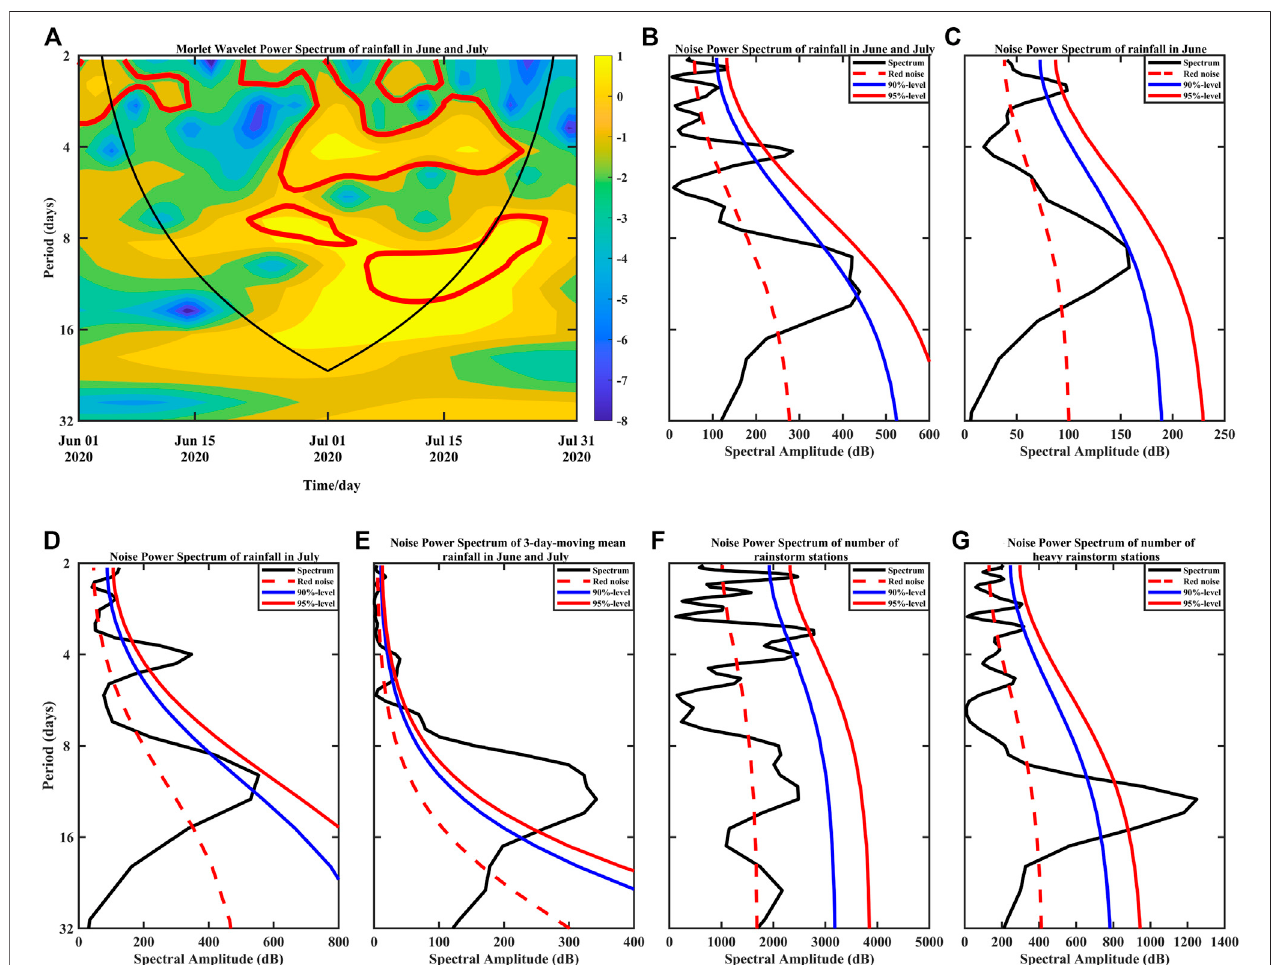
FIGURE 5 | (A) Local wavelet power spectrum of series of daily averaged precipitation from June 1, 2020, to July 31, 2020, in Figure 1B using Morlet wavelet analysis (thick red contour encloses regions of greater than 95% con fi dence for a red-noise process). (B) Noise power spectrum analysis of series of daily mean precipitation in Figure 2B (dashed red line is for red noise spectrum). Solid blue/red line is for 95/90% con fi dence level for spectrum. (C) as in (B) but for series of precipitation in June 2020. (D) as in (B) but for series of precipitation in July 2020. (E) as in (B) but for series of daily 3-day moving mean averaged precipitation in Figure 2B . (F) as in (B) but for series of daily number of rainstorm (daily rainfall ≥ 50 mm) stations. (G) as in (B) but for series of daily number of heavy rainstorm (daily rainfall ≥ 100 mm) stations.